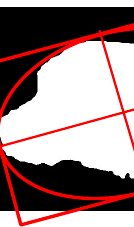
Figure 6. Example of symmetry estimation. Ellipse and rectangle inscribed in the outline of the possible case of melanoma, identification of midpoints, and